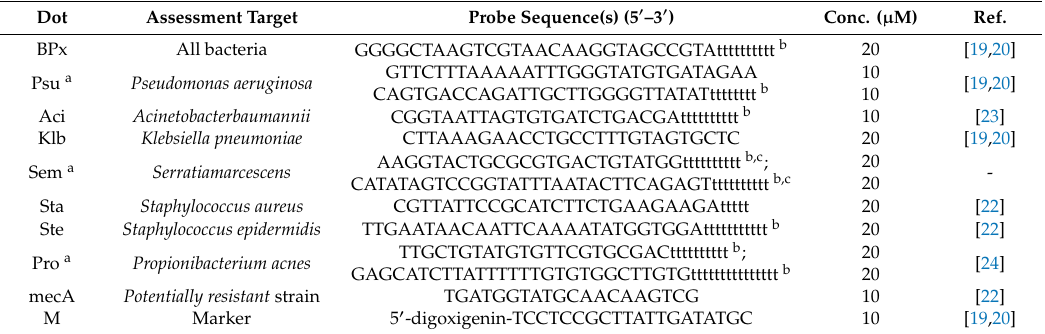
TTGCTGTATGTGTTCGTGCGACtttttttttt b ; GAGCATCTTATTTTTTGTGTGGCTTGTGttttttttttttttt